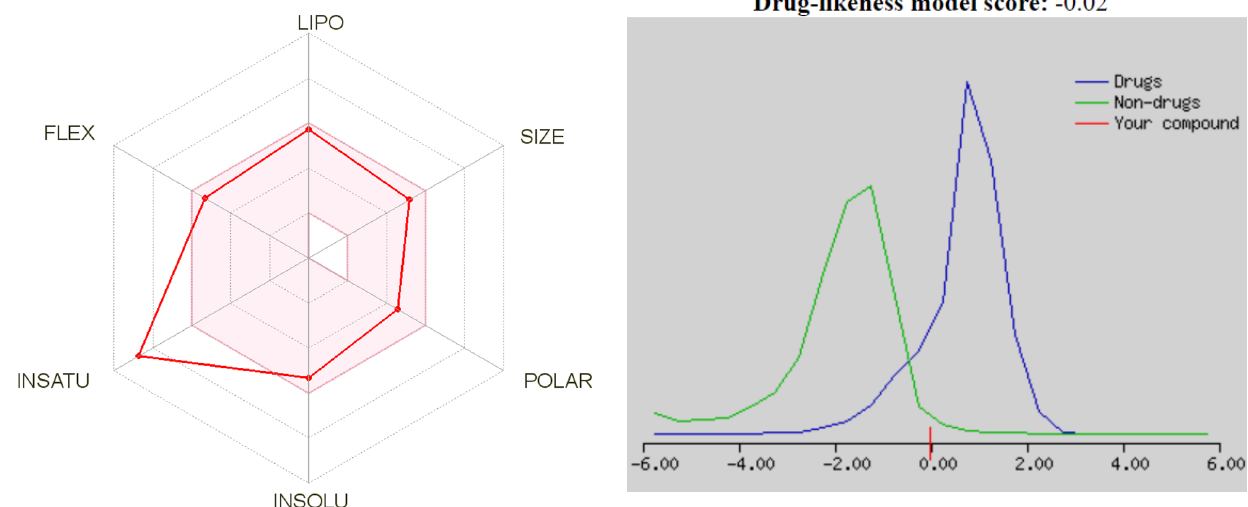
Figure 10. The bioavailability radar (left) [39,66] and drug-likeness model score plots [68] of 2 . Table 8. Physicochemical, lipophilicity, water solubility, pharmacokinetic, drug-likeness, and me- dicinal chemistry properties obtained from the SwissADME website for 2 .